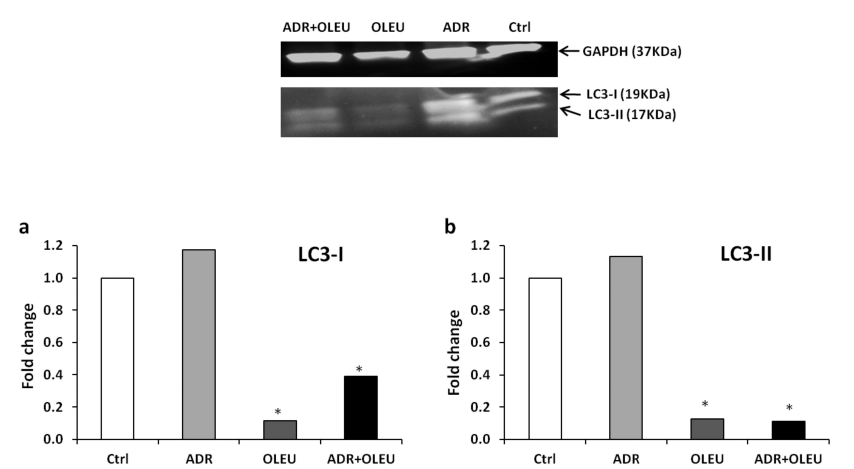
Figure 4. Representative western blot densitometry of the expression of the unconjugated (LC3-I) and conjugated forms (LC3-II) of LC3 in MG-63 cells, after ADR (Adriamycin), OLEU (Oleuropein), ADR + OLEU treatments, normalized against GAPDH. Protein ratios of LC3-I ( a ) and LC3-II ( b ) were used to quantify fold change relative to control. * p < 0.05 compared to control cells. LC3: microtubule-associated protein 1A/1B-light chain 3; GAPDH: Glyceraldehyde 3-phosphate